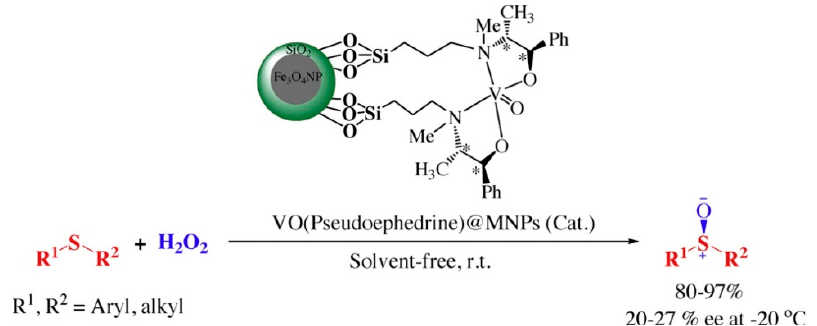
Figure 4. Chemoselective oxidation of sulfides to sulfoxides by means of VO(pseudoephedrine)- functionalized MNPs. Reprinted with permission from [56], Copyright Elsevier, 2015.